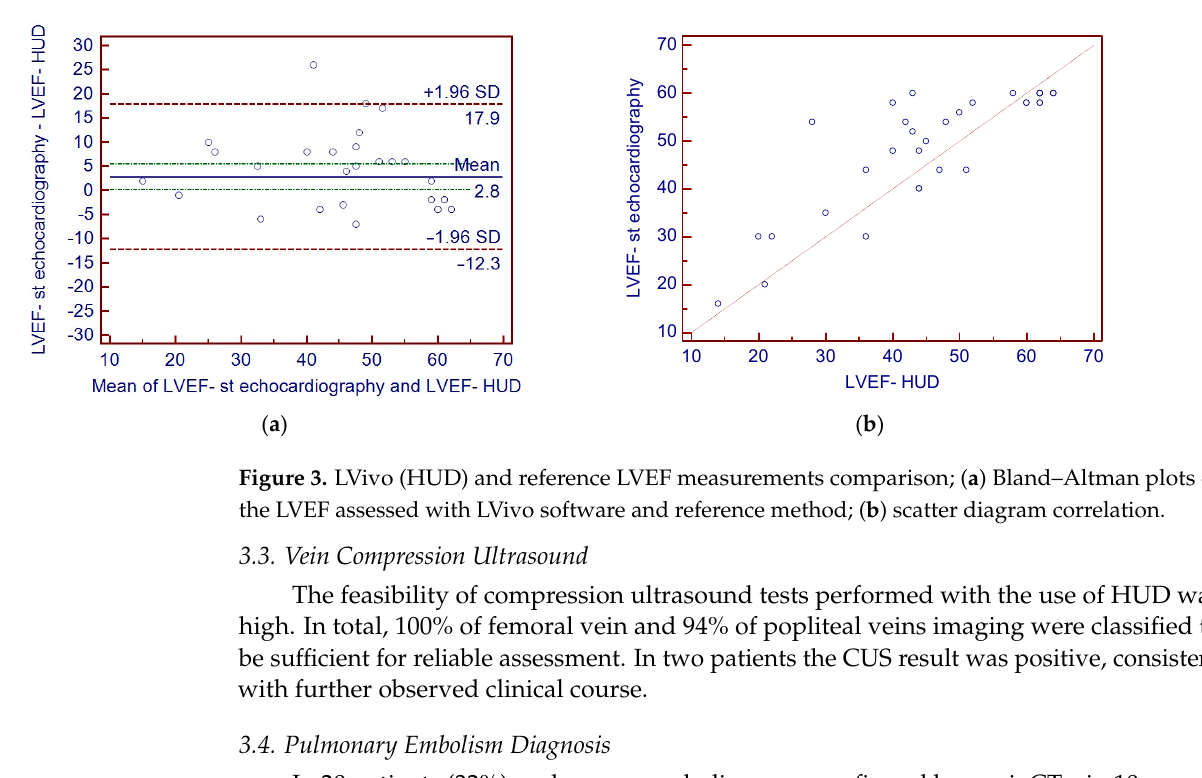
Figure 2. Examples of LVivo software implementation in patients with COVID-19; software failed to calculate LVEF in 29 (46%) cases. Four-chamber apical view, ( a ) successful left ventricle ejection fraction measurements with LVivo software, ( b , c ) examples of LVivo software failure in endocar- dial border detection examples of lung ultrasonography performed with HUD.